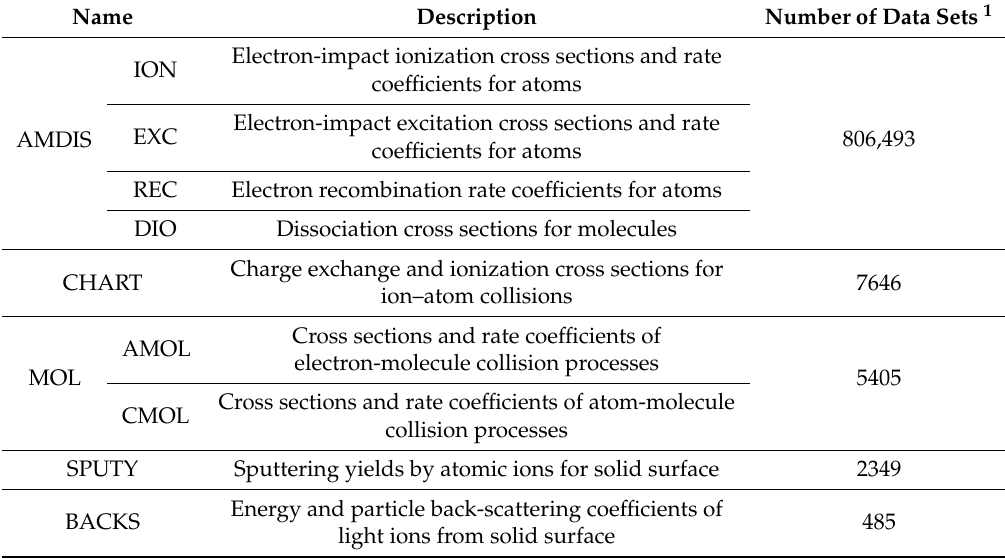
Table 1. List of sub databases in the NIFS Atomic and Molecular Numerical